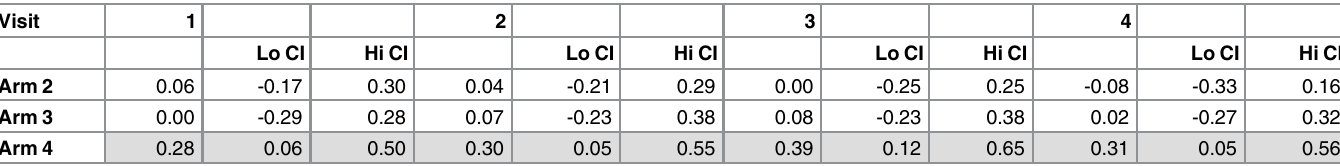
Table 2. Time varying difference in the non-parametric cumulative incidence function (CIF) by trial arm (arm 1 the reference). Arm 1 — Standard of care; Arm 2- Structural-level stigma intervention; Arm 3 — Individual-level HIV intervention; Arm 4 — Both structural and individual level interventions.